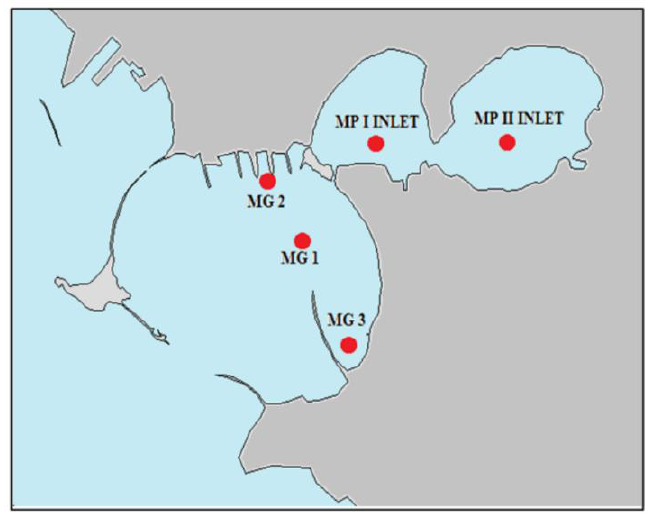
Figure 3. Location of the station points where particles are released in the Particle module (PT).